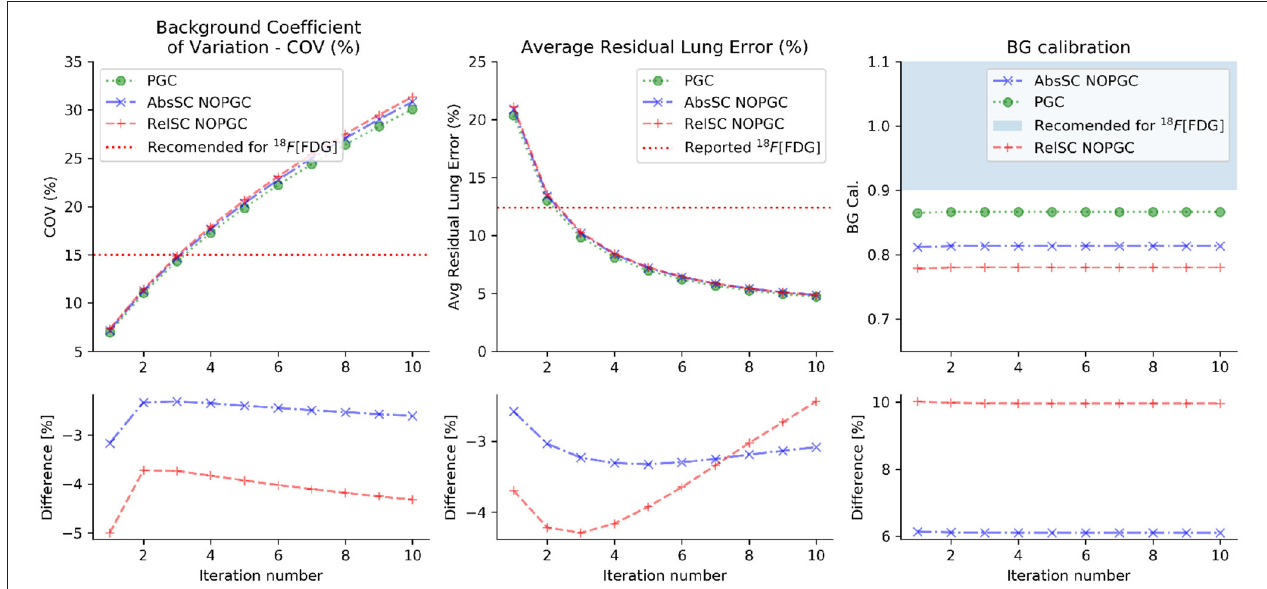
FIGURE 1 | Noise level (COV), average residual lung error and local cross-calibration for 44 Sc obtained as a function of the tested iteration numbers for the different evaluated corrections (absolute scatter correction, relative scatter correction and PGC). The differences (in %) between the absolute or relative scatter correction in respect to the PGC is displayed in the lower plots. All reconstructions were performed (similarly to clinical 18 F PET setup) with absolute scatter correction, PSF and TOF.